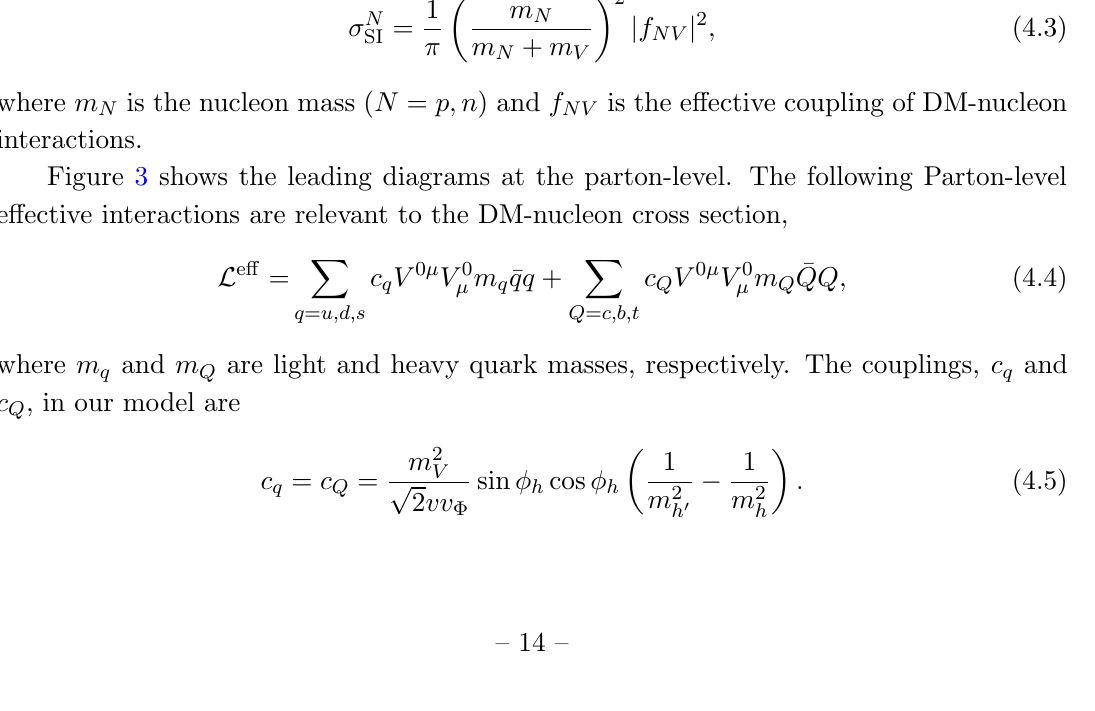
Figure 2 . The production cross section of V The left panel shows the cross section of pp ! V + V 0 , the right shows pp ! V (cid:0) V 0 , and the bottom shows pp ! V + V (cid:0) . In each (cid:12)gure, the black line shows the Wino production cross section and the dashed (dotted) line shows the V (cid:6) for m Z 0 ;W 0 = 1 : 5 m V ( m Z 0 ;W 0 = 1 : 3 m V